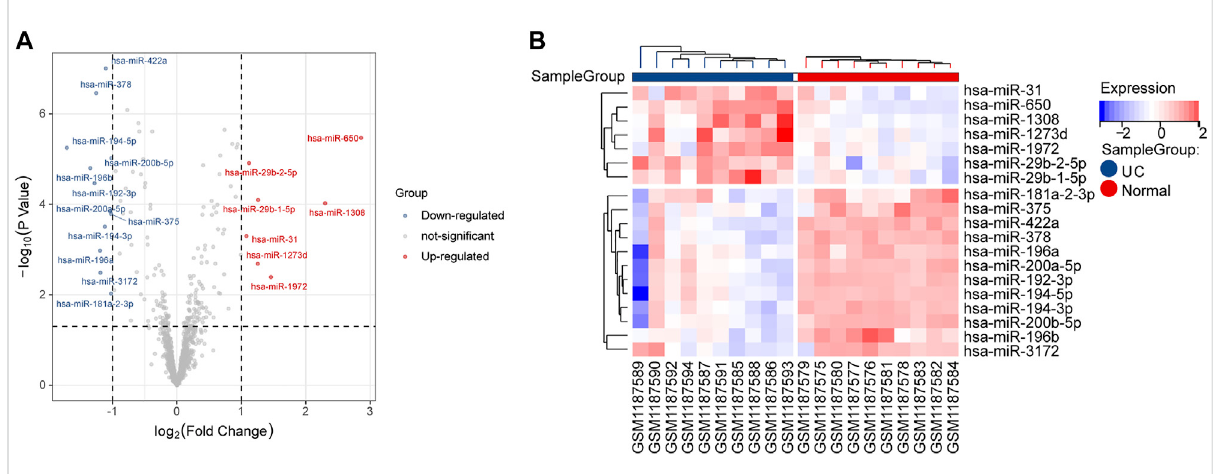
FIGURE 2 DE-miRNA screening. (A) Volcano plots of DE-miRNAs from GSE48957. (B) Heatmap of DE-miRNAs from GSE48957.